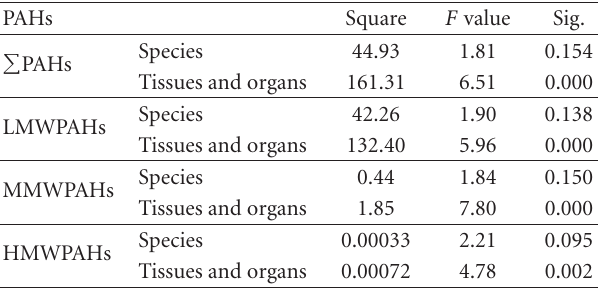
Table 4: ANOVA results of wet weight-based PAH